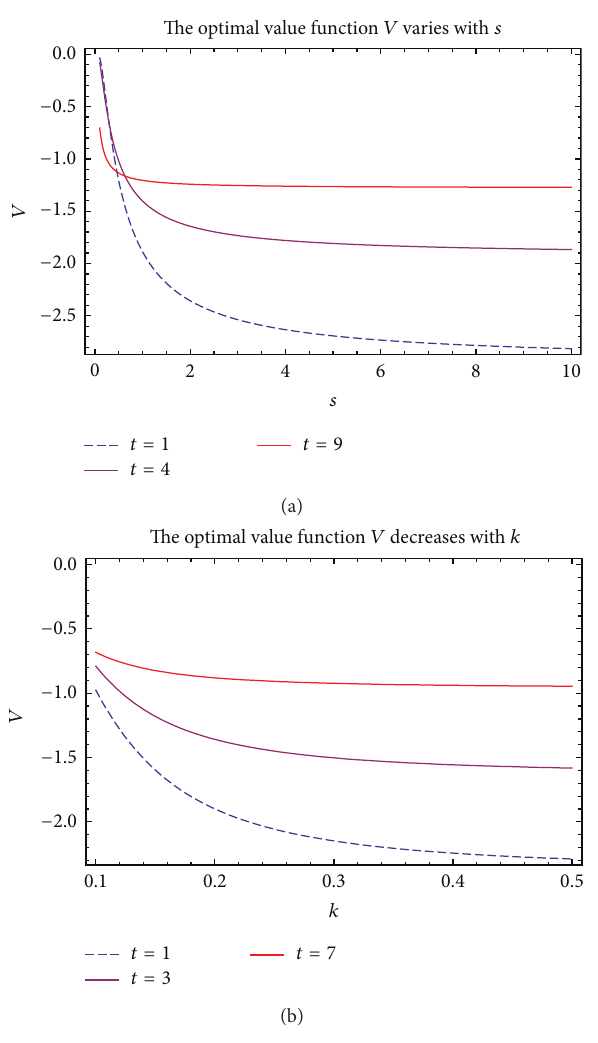
Figure 4: (a) The optimal value function 𝑉 decreases with 𝑠 . (b) The value function 𝑉 decreases with 𝑘 .